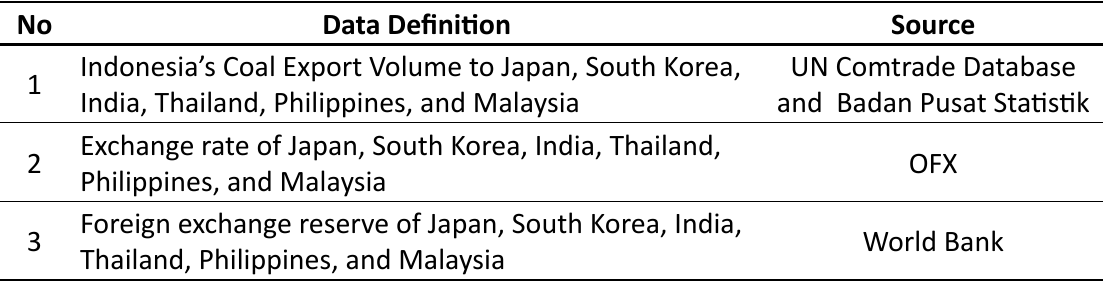
Table 1: Source of